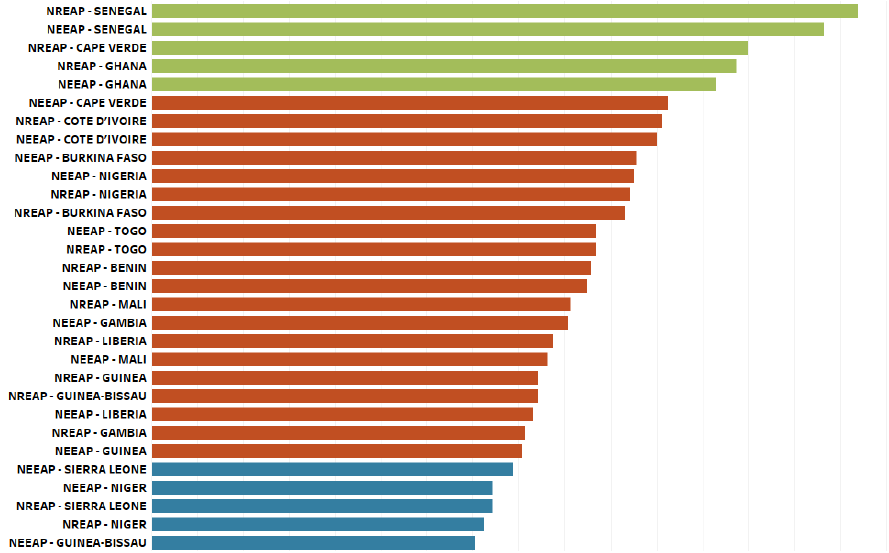
Figure 6. Graph of NREAP and NEEAP policies